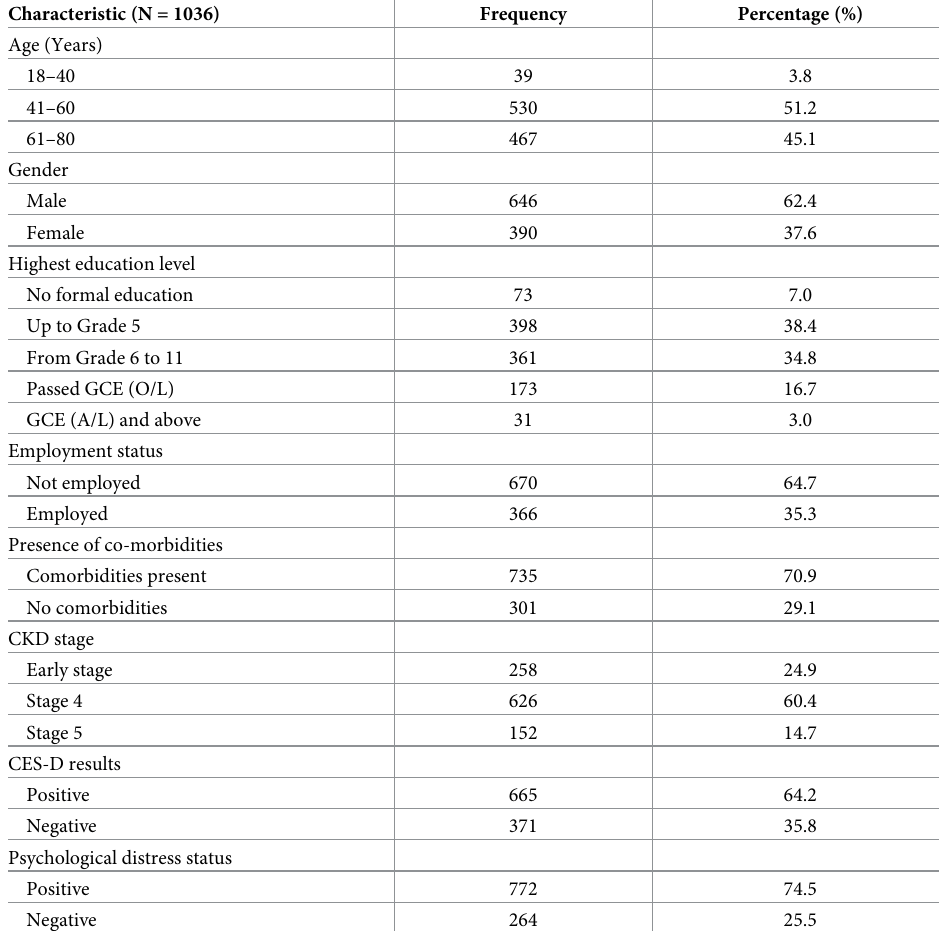
Table 1. Characteristics of the